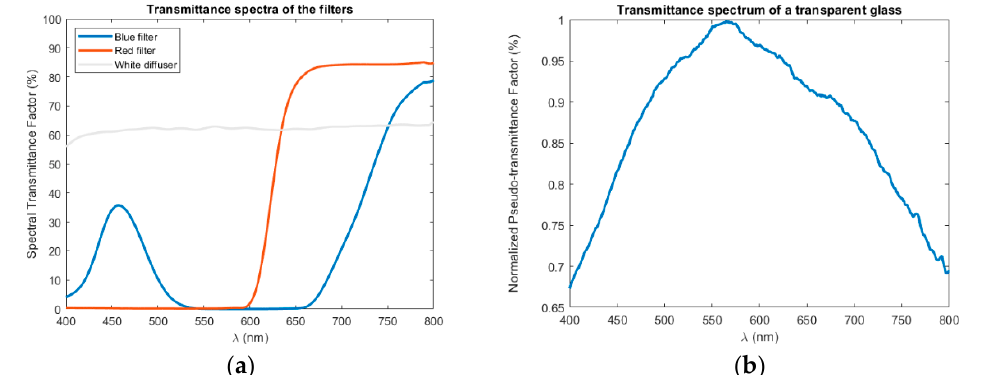
Figure 2. ( a ) Transmittance spectra of the color filters. ( b )Pseudo-Transmittance spectra of the sample